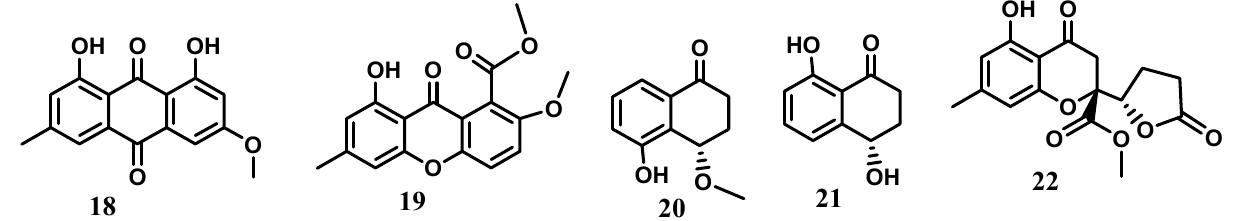
Figure 2. Xanthones, quinones, and coumarins from the genus Cytospora. From the extracts of the walnut tree pathogenic fungus Cytospora sp. CCTU A309, the terphenylquinone derivatives, cytosporaquinones A ‒ D ( 23 ‒ 26 ), leucomelone ( 27 ), and atromentin ( 28 ) were isolated [22]. Cytosporaquinones A ‒ D ( 23 ‒ 26 ) exhibited significant cytotoxicity against the mouse fibroblast L929 and cervix carcinoma KB-3-1 cell lines, with IC 50 values ranging from 2.4 to 26 μ g/mL. Furthermore, cytosporaquinones B ‒ D ( 24 ‒ 26 ), and leucomelone ( 27 ) showed interesting antiviral activity against the hepatitis C virus (HCV), while only moderate antimicrobial effects were observed against twelve bacterial strains, with IC 50 values ranging from 16.66 to 66.66 μ g/mL [22]. Leucomelone ( 27 ) and atromentin ( 28 ) previously obtained from the solid state fermentation of an unidentified fungus F010248 isolated from a soil sample collected in a corn field around Kongju city (Korea) were shown to be the first inhibitors specific to enoyl-ACP reductase (FabK) of Streptococcus pneumoniae [45]. The dihydroisocoumarin derivative 3,5-dimethyl-8-meth- oxy-3,4-dihydroisocoumarin ( 29 ) was also obtained from Cytospora sp. strain CCTU A309 [22], while its congeners 3,5-dimethyl-8-hydroxy-7-methoxy-3,4-dihydroisocoumarin ( 30 ), 3,5-dimethyl-8-methoxy-3,4-dihydroisocoumarin ( 31 ), 3,5-dimethyl-8-hydroxy-3,4- dihydroisocoumarin (5-methylmellein, 32 ), 8-hydroxy-5-hydroxymethyl-3-methyl-3,4-di- hydroisocoumarin (5-hydroxymethylmellein, 33 ), 4,8-dihydroxy-3,5-dimethyl-3,4-dihy- droisocoumarin (4-hydroxy-5-methylmellein, 34 ), and tetralone 4,8-dihydroxy-1-tetralone (isosclerone, 35 ) were isolated from a culture filtrate of Cytospora eucalypticola [46] (Figure 3). The fungus was originally isolated from the bark of Eucalyptus perriniana cv. Spinning Gum (Myrtaceae) growing at the Royal Botanic Gardens, Kew [46]. These isocoumarins are mildly antifungal and antibacterial towards Gram-positive bacteria. Nevertheless, in the antifeedant assay against the larvae of Spodoptera littoralis , 5-hydroxymethylmellein ( 33 ) showed activity at 100 ppm (feeding index (mean S.E.M.) 42.1 ± 6.42; p < 0.05), whereas 5-methylmellein ( 32 ) did not influence any feeding (feeding index, ‒ 30.1 ± 20.14; p > 0.05), Figure 3. Terphenylquinones and dihydroisocoumarin derivatives from the genus Cytospora. suggesting that C-5 substituent influences the behavioural response of the larvae [46]. The pyrone and isocoumarin hetero-dimers that possess an unprecedented skeleton with a polyoxygen-hetero 6/6/6/6 tetracyclic fused ring system named cytospone A ( 42 ) and three of its biosynthetic precursors, cytospones B–D ( 43 – 45 ), were isolated from Cytospora rhizophorae A761 [7] (Figure 4). The structure of cytospone A represents the first family of natural hetero-dimers comprising pyrone and isocoumarin moieties